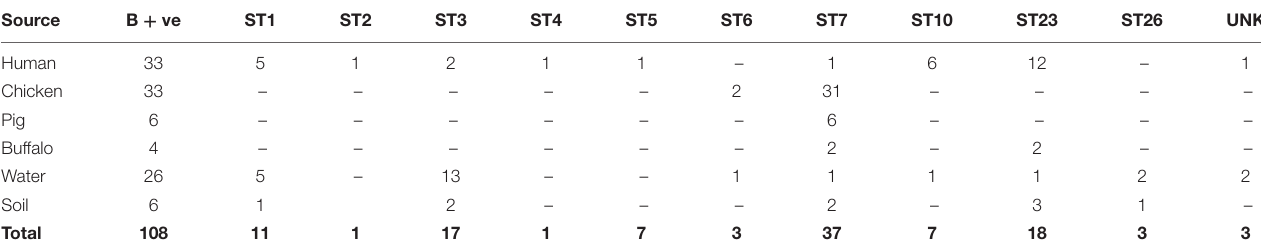
TABLE 2 | Prevalence and subtypes of Blastocystis in human, animal, water and soil samples. Source B + ve ST1 ST2 ST3 Human